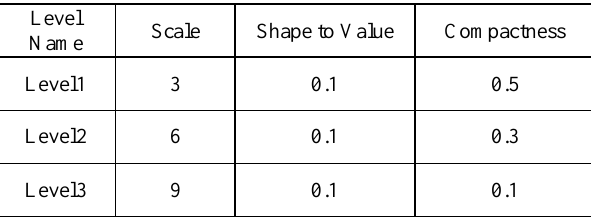
Table 2. Parameter settings for image segmentation